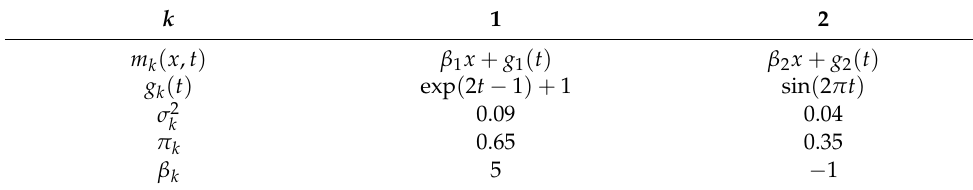
Table 1. The K = 2 component